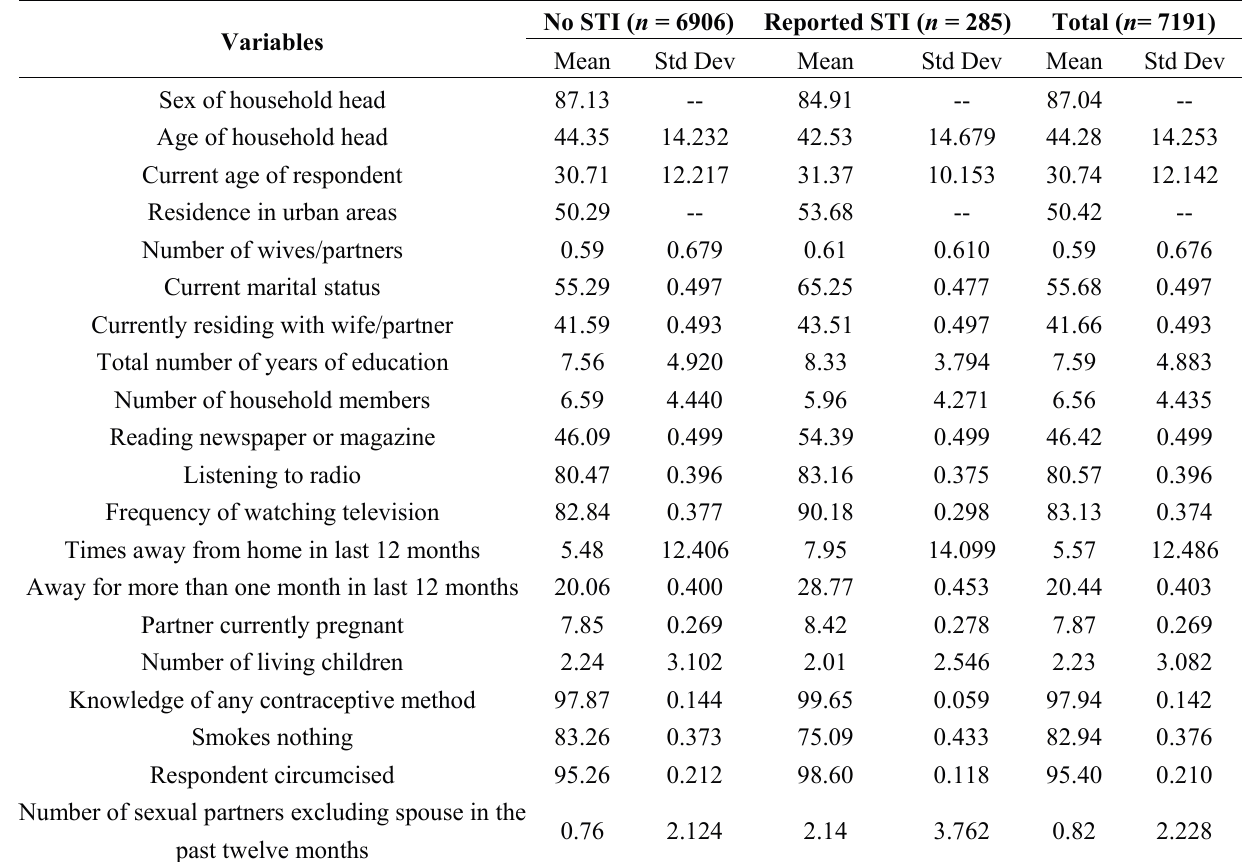
Table 1. Demographic characteristics and sexual behaviour of